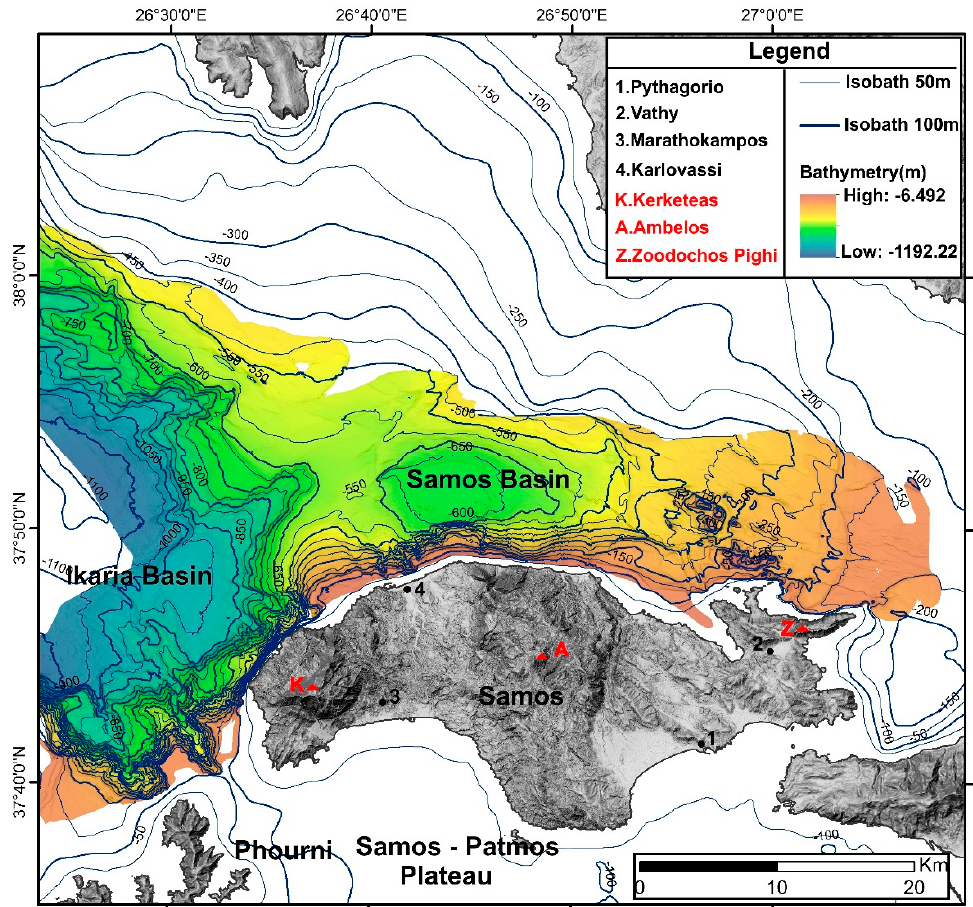
Figure 3. Detailed swath bathymetry map of the Samos Basin using 50 m isobaths. The surrounding offshore contours are obtained from EDMONET.